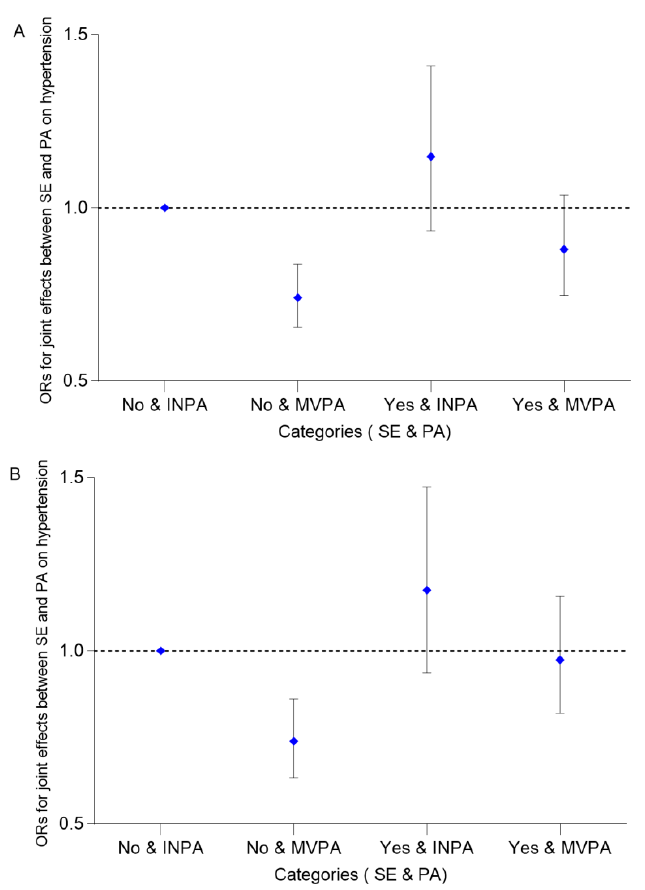
Figure 4. The joint effects between SE and PA on hypertension. ( A ) All participants ( n = 14,456), p for interaction = 0.077. ( B ) Participants aged <60 years ( n = 10,139), p for interaction = 0.043. Models were adjusted for age, sex, race, education level, marital status, family PIR, and survey wave. Abbreviations same as in Table 1 and Figure